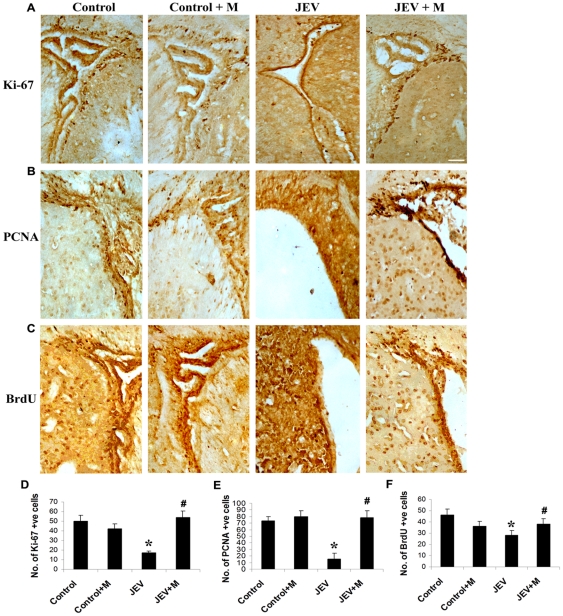
Replenishment of proliferating cells in the infected adult SVZ by minocycline administration.Cryostat sections of brains from control, control+M, JEV and JEV+M animal groups were stained for markers of proliferation- Ki-67 (A) and PCNA (B) and developed using DAB substrate. BrdU was also administered to animals for 5 days at 50 mg/kg body weight and then animals were sacrificed 6 h after the last BrdU injection. Cryostat sections from BrdU administered animals from all groups were stained using anti-BrdU antibody (C). Discrete population of cells in control SVZ show localisation of all the antigens. While reduced population of all three cell types were observed in JEV-infected SVZ, however, they were replenished in the SVZ from JEV+M animals. The graphs represent the number of Ki-67 (D), PCNA (E) and BrdU (F) positive cells in the SVZ from the different treatment groups. Cell counting was done using5 serial sections from 3 animals with Leica IM50 software. Values represent means ± SEM from three animals in each group (* significant change from control, p<0.05; #significant change from JEV-infected animals, p<0.05); scale bar is 50 µ.